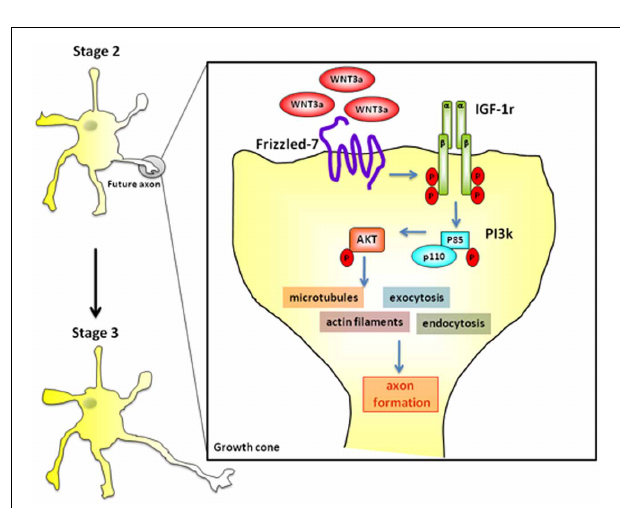
FIGURE 9 | Wnt3a binds to Fz7 and cross-activate the IGF-1-PI3k-Akt pathway inducing initial axonal outgrowth and neuronal polarization. Challenging with 1.35nM Wnt3a resulted in a polarized distribution of active (phosphorylated) IGF-1r and phosphorylated p85, the PI3k regulatory subunit, to one neurite of cells in stage 2 (see Figure 2F